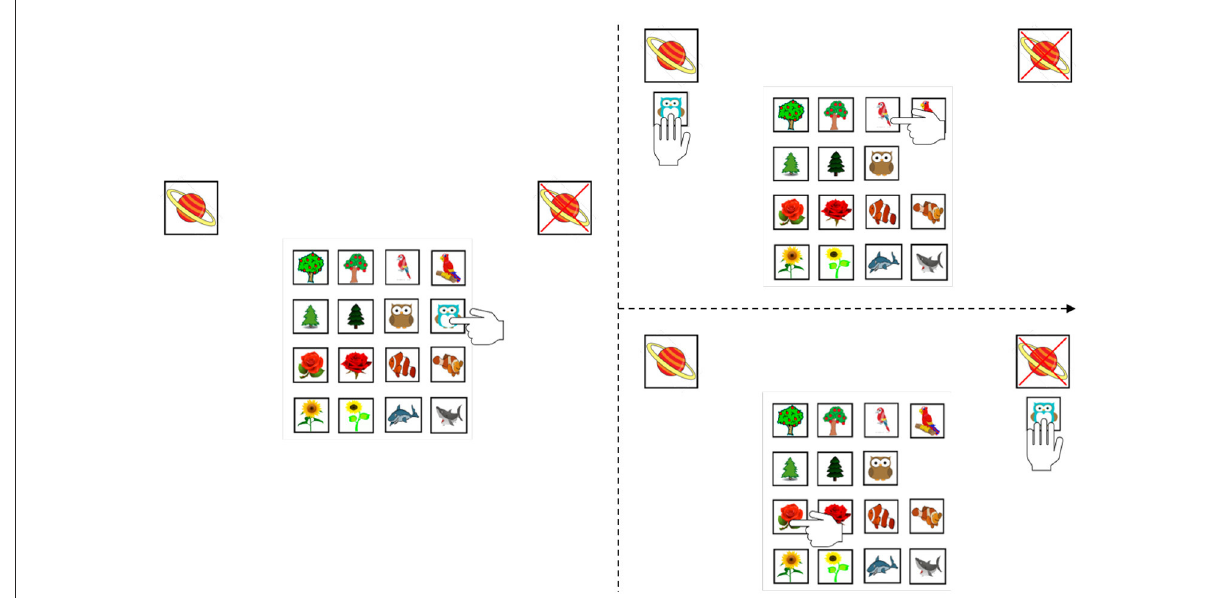
FIGURE1 Stimuli display and illustration of the search path. These 16 cards are grouped into three hierarchical levels in a 4-by-4 grid display: 2 superordinate levels (i.e., animals and plants), 4 basic levels (i.e., fish, birds, trees and flowers), and 8 subordinate levels (i.e., owls, parrots, clownfish, shark, pine/Christmas trees, apple trees, roses and